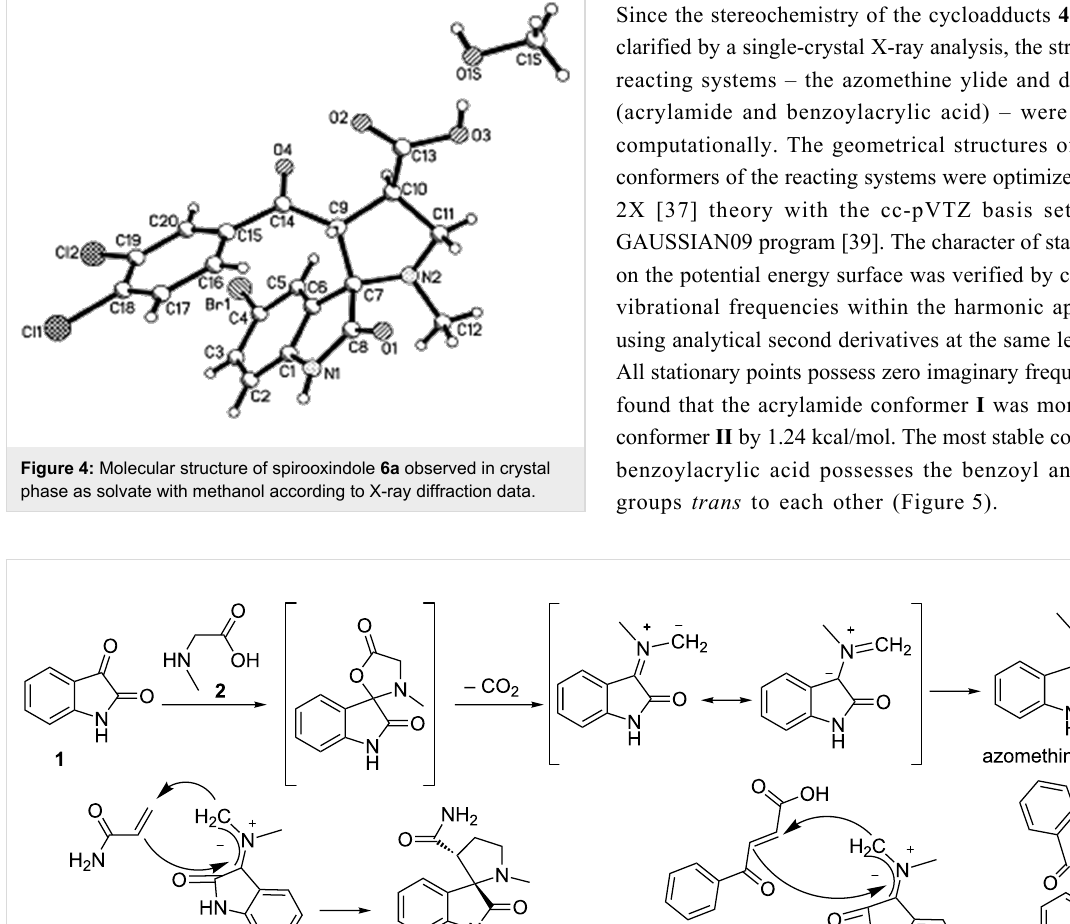
A single crystal X-ray study of compound 6a provided a conclusive support for the assigned structure (Figure